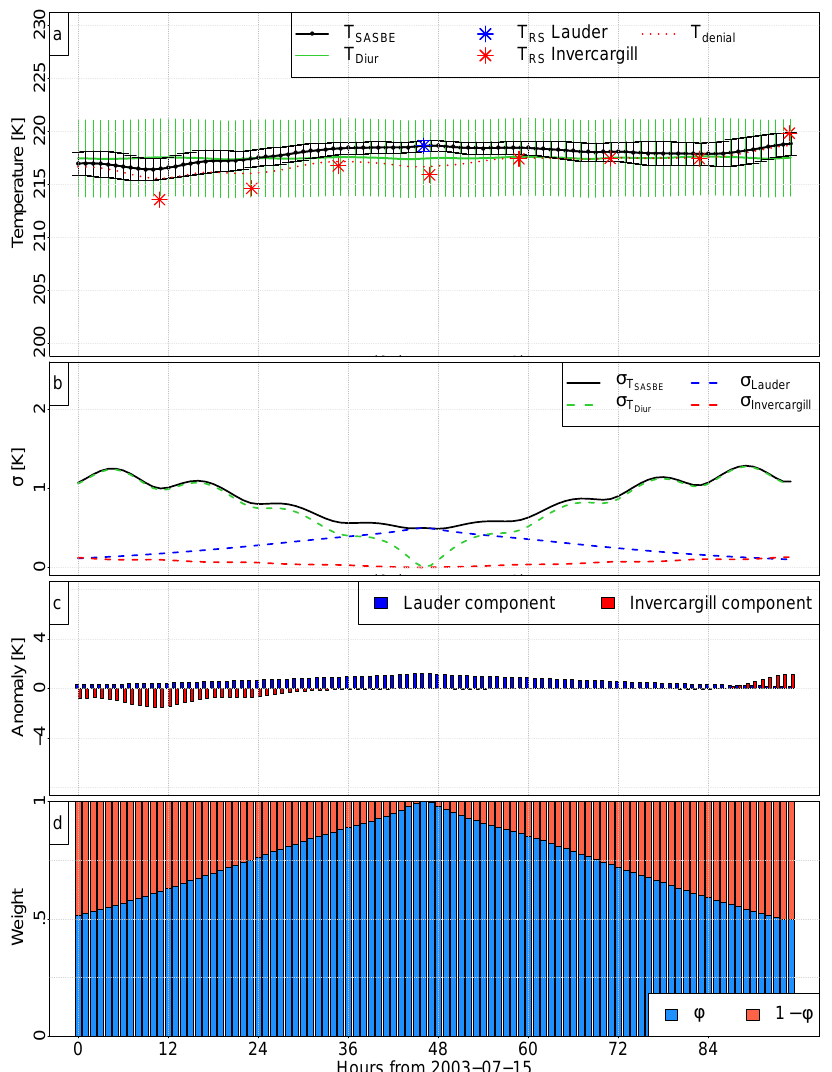
Figure 9. As in Fig. 4, but for 4 days in July 2003 at